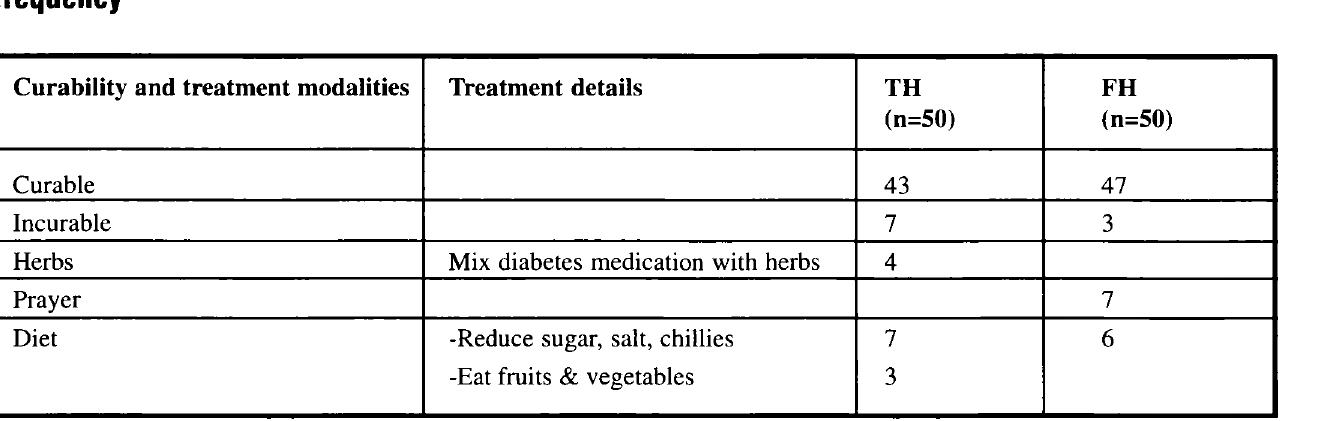
Table 3: Curability and treatment of diabetes by traditional healer (TH) and faith healer (FH) by frequency